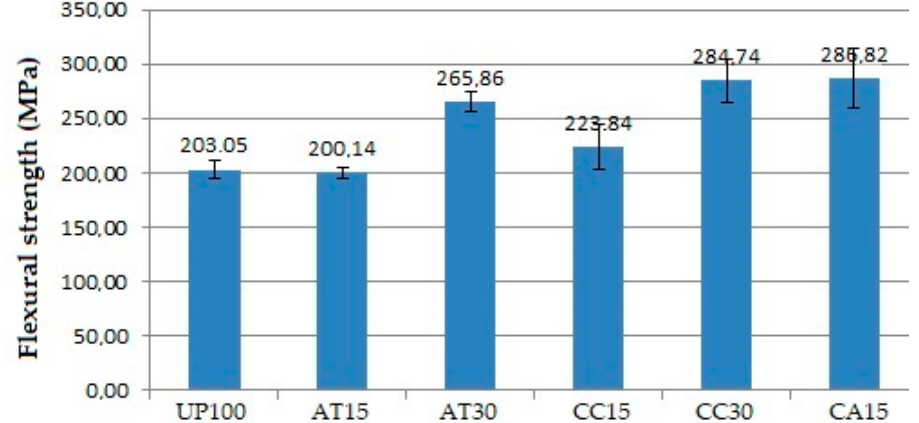
Figure 6. Flexural strength of the GFRP samples.